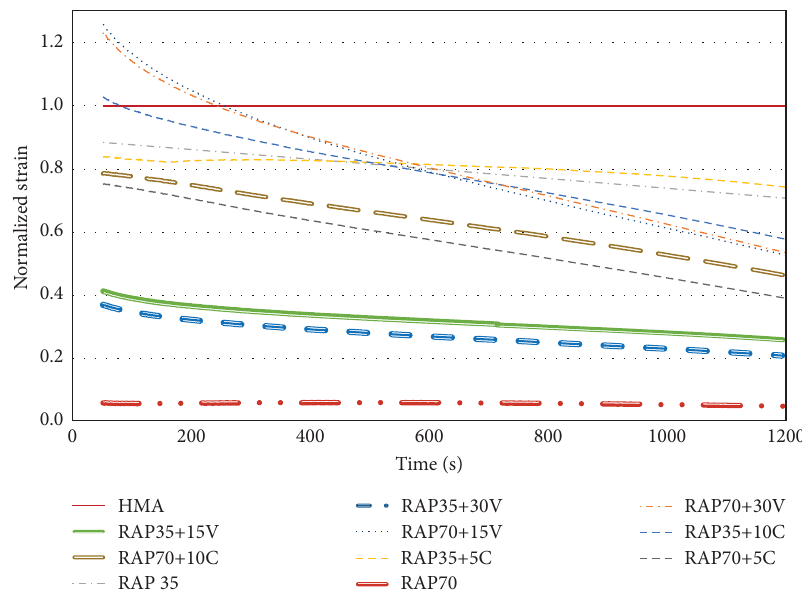
Figure 5: Efect of RAP and rejuvenating agents on the normalized strain of asphalt